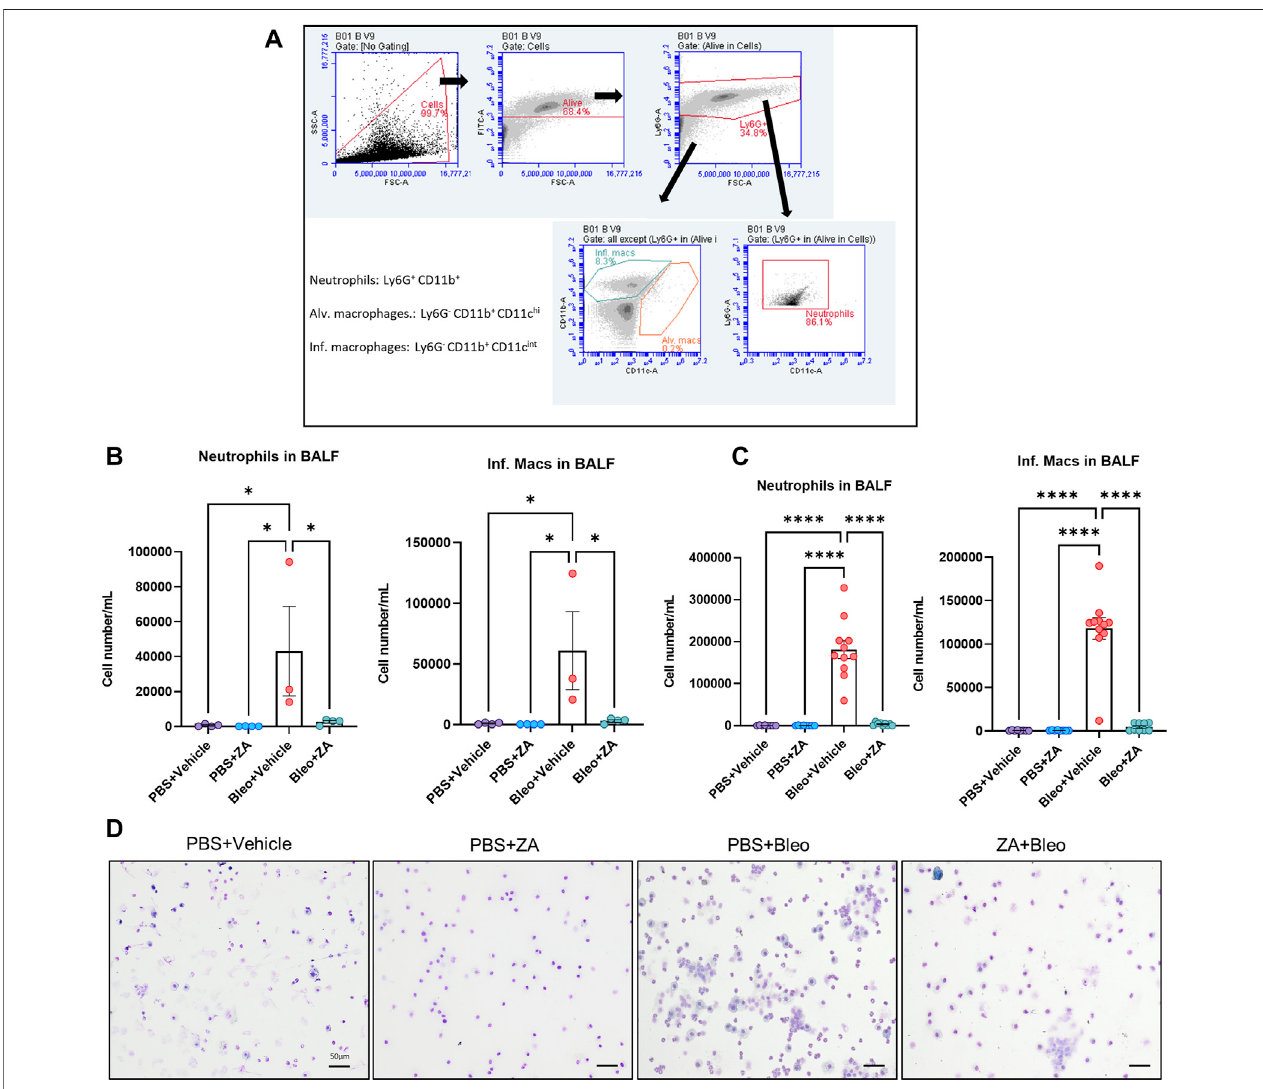
FIGURE 3 | In fl ammatory cell in fl ux measured in murine bronchoalveolar lavage fl uid (BALF). Murine BALF was assessed for neutrophils and in fl ammatory macrophages (B,C) using fl owcytometry, withtherepresentativegatingstrategydepictedinset (A) . Decreased numbers ofneutrophilsand in fl ammatorymacrophages were detected in response to ZA (i.t.) treatment, with increased signi fi cant differences reported between the neutrophils and in fl ammatory macrophages of mice treated with ZA (i.p.). No signi fi cant differences were reported for alveolar macrophage numbers (not shown). In fl ammatory cell numbers were compared to the vehicle/ bleomycin group using a one-way ANOVA followed by a Dunnett ’ s post-hoc test (* p < 0.05; ****p < 0.0001). (D) Giemsa-Wright stained cytospin slides showing PBS/ bleomycin BALF samples containing enlarged in fl ammatory macrophages, with ZA (i.p.) treatment reducing the presence of in fl ammatory macrophages. Scale bar = 20 μ